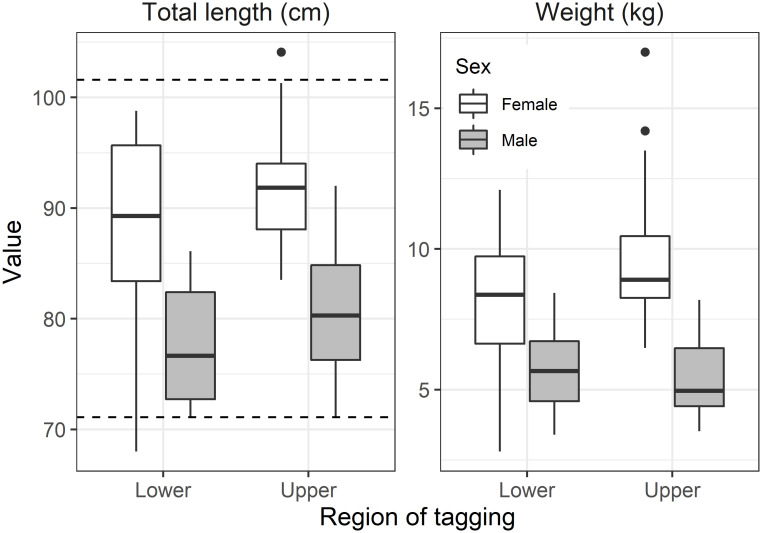
Distributions (box whisker plots) of total length (cm; left panel) and weight (kg; right panel) of Hudson River striped bass receiving transmitters by tagging region and sex.Horizontal dashed lines represent the Hudson River no-take slot limit between 71.1 and 101.6 cm Total Length.